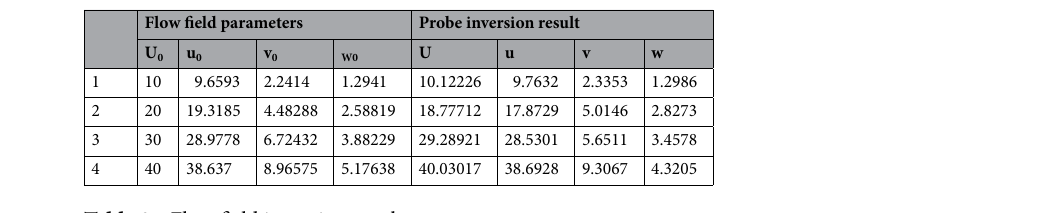
Table 2. Flow field inversion results.